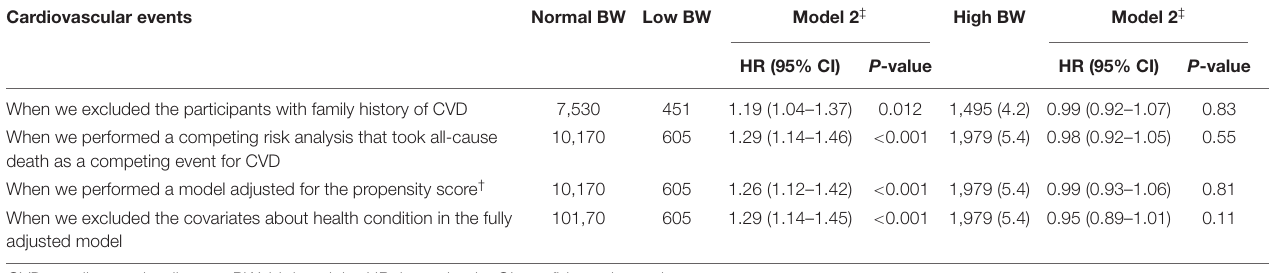
TABLE 4 | Sensitivity analysis of associations between birth weight and risk of cardiovascular outcomes. Cardiovascular